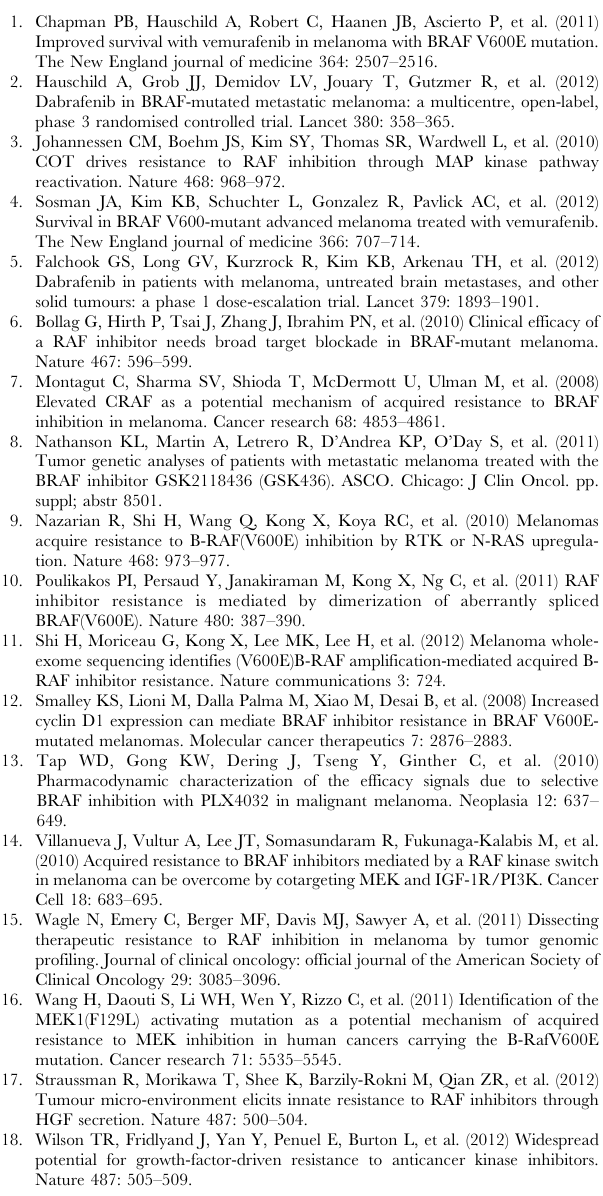
Figure S3 BIM and Apptosis in Xenografts. IHC for BIM in xenograft tumors from mice treated with vector, ABT, PLX or the combination of ABT + PLX ( A ) and the detection of apoptosis in these tumors using a TUNEL assay ( B ). Table S1 Patient Characteristics. Patients with metastatic melanoma containing BRAF V600E mutation (confirmed by genotyping) were enrolled on clinical trials for treatment with a BRAF inhibitor (vemurafenib) or combined BRAF + MEK inhibitor (dabrafenib + trametinib). Listed are patient age, site of